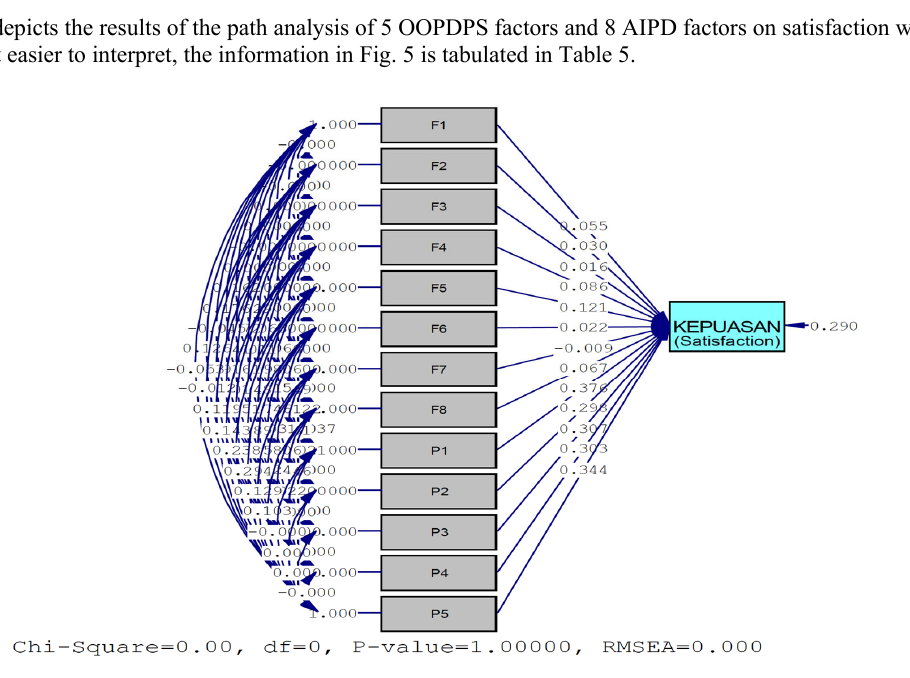
Fig. 5. Path Coefficient of OOPDPS Factor and AIPD Factor on Satisfaction with the OOPDPS Source: LISREL 8.80